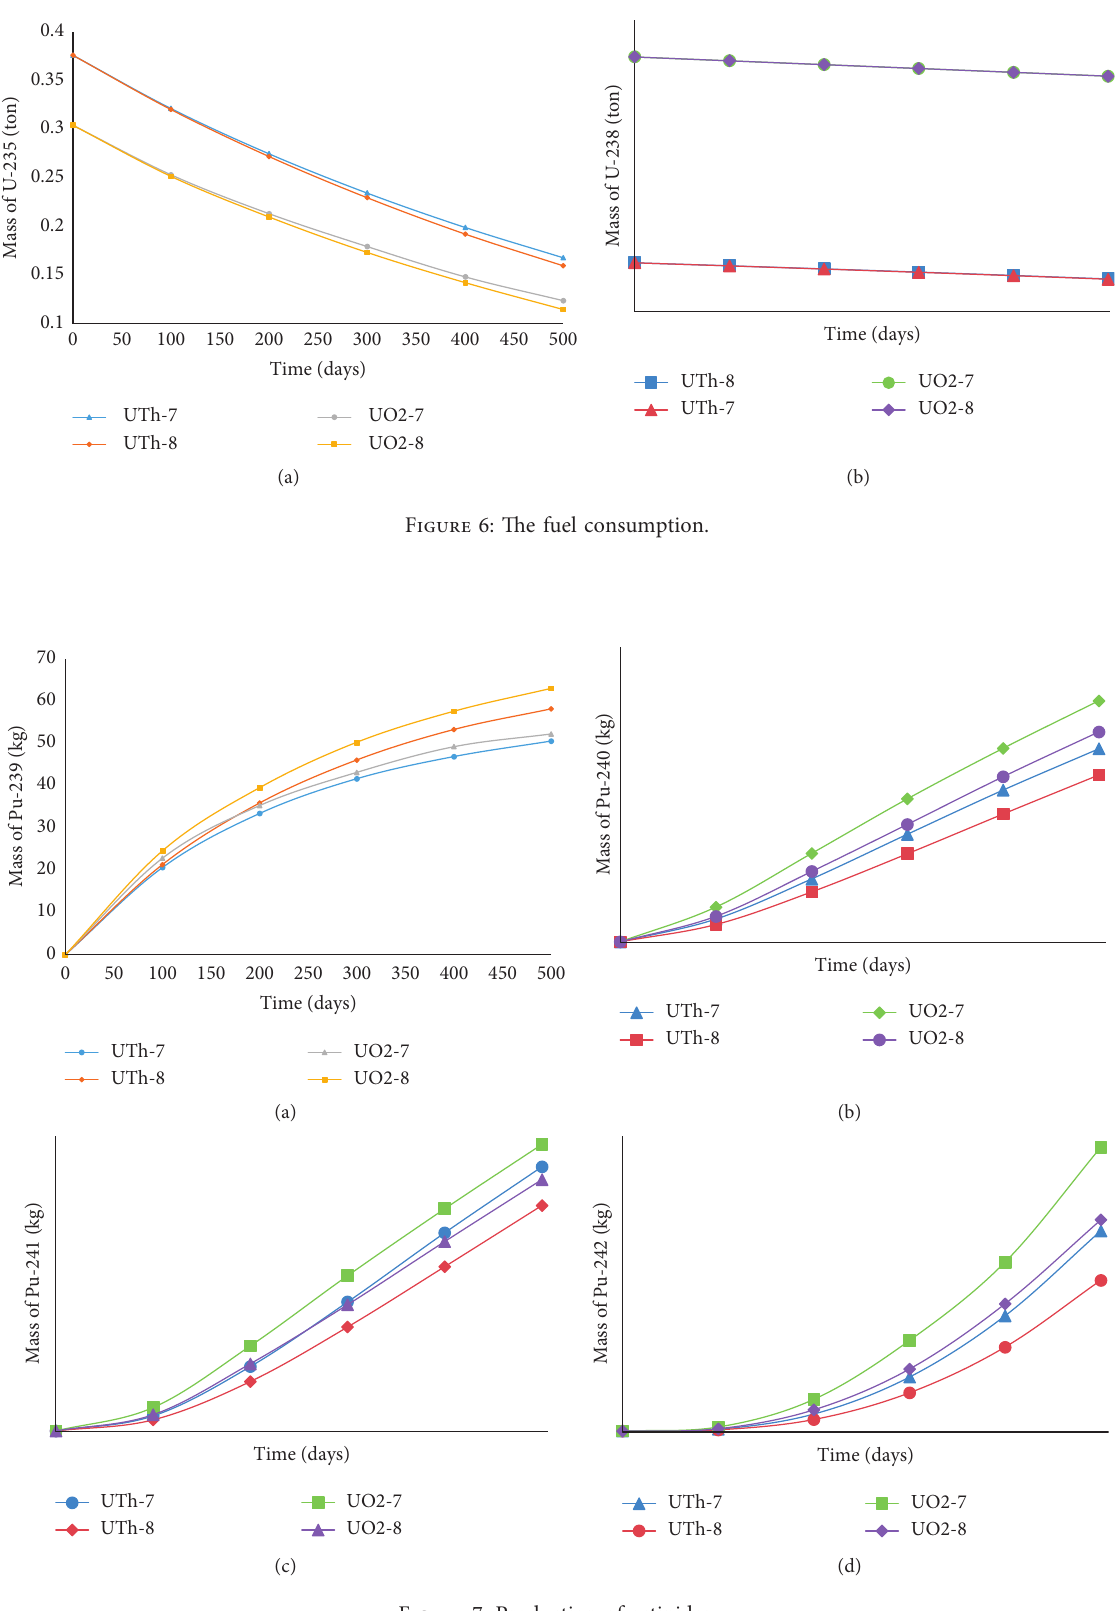
Figure 6: The fuel consumption.